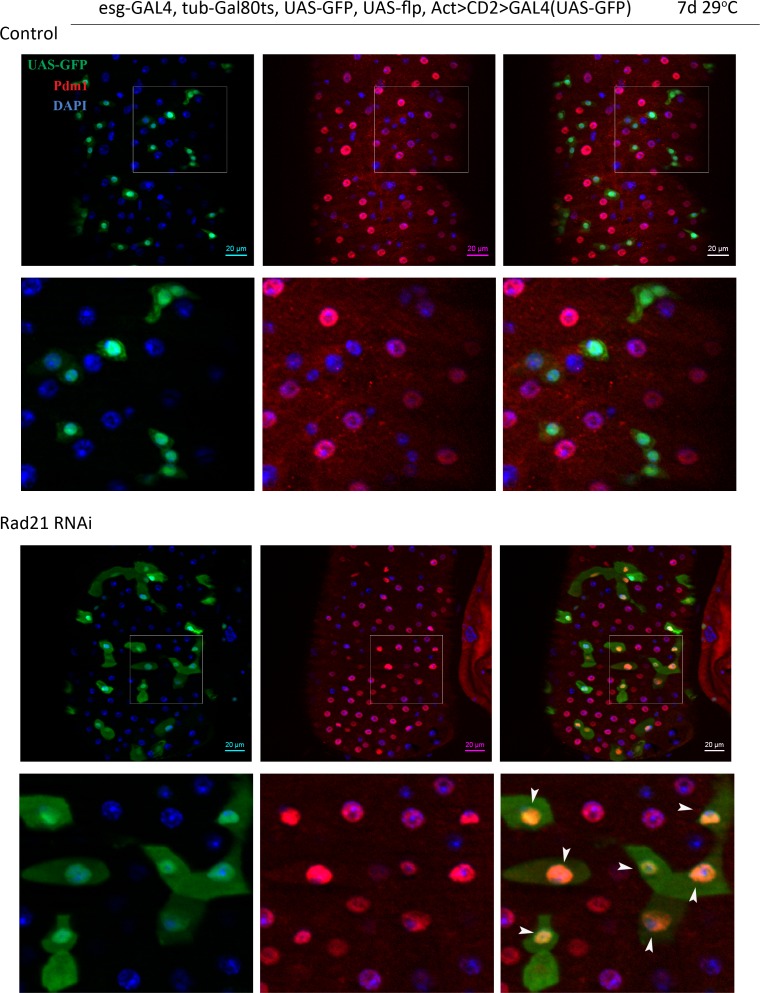
Esg-FlipOut (F/O) midguts expressing UAS-GFP alone (control) or expressing rad21RNAi.Samples were stained for GFP and Pdm1. Differentiated cells are labeled with white arrowheads. Scale bars, 20 µm.